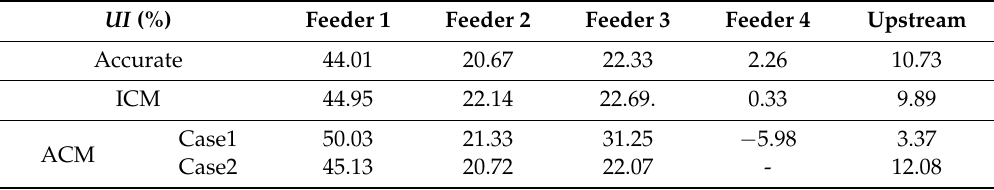
Table 8. Sensitivity study results for unbalance